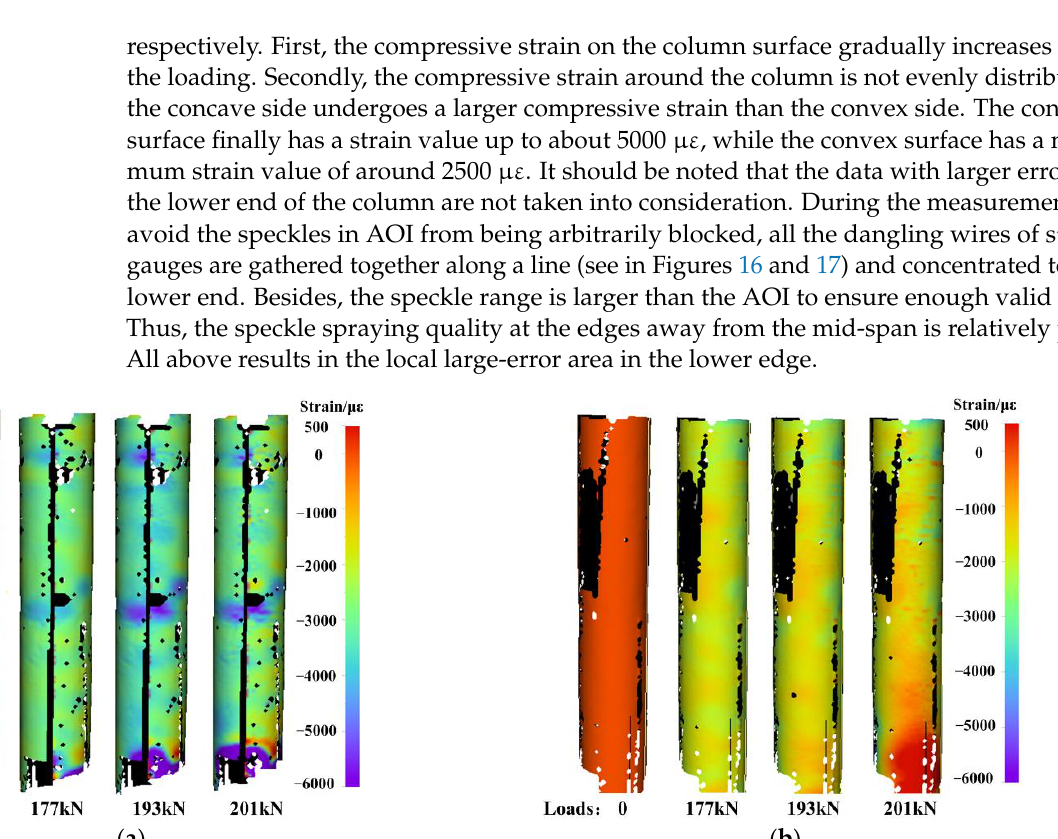
Figure 22. Displacement evolution on: ( a ) concave side; ( b ) convex side under different axial loads.